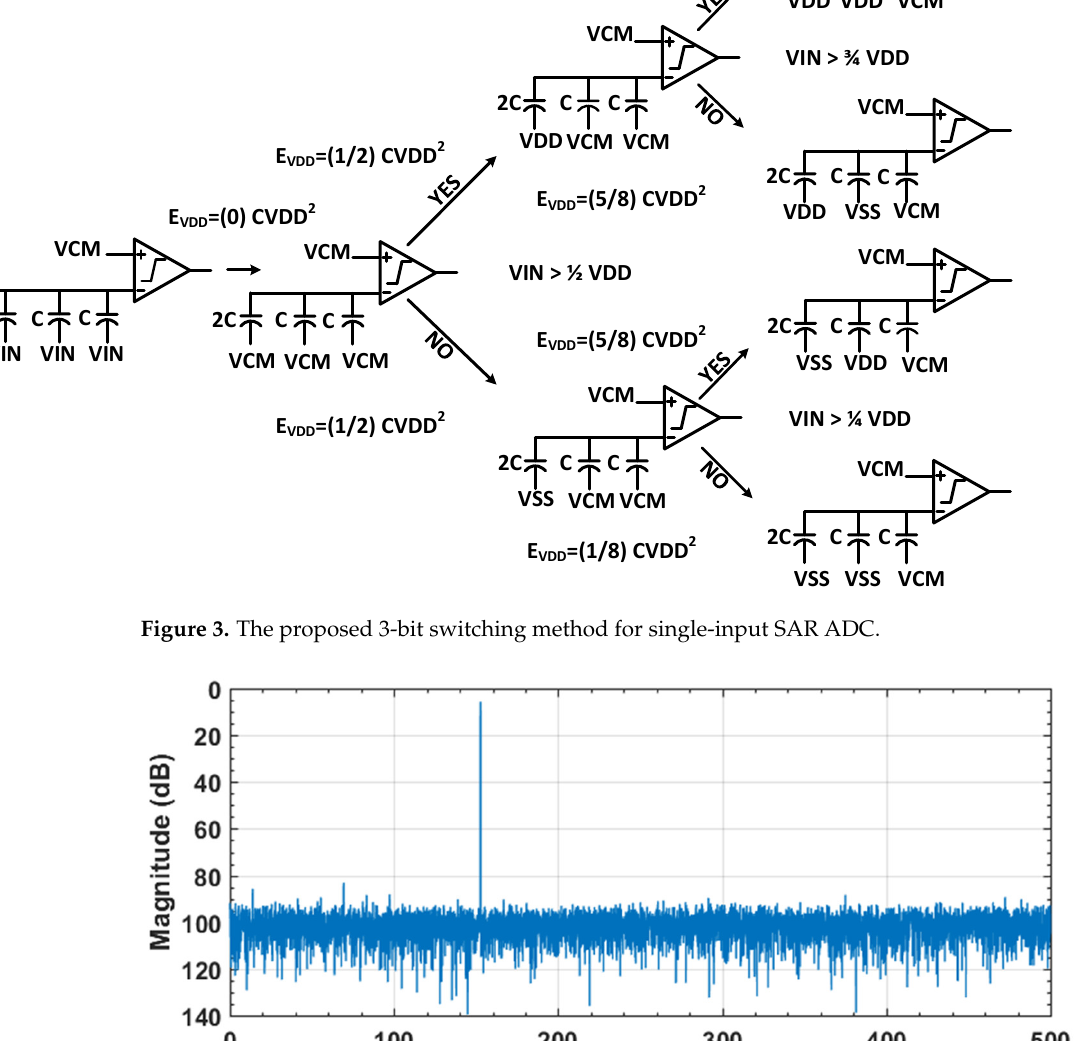
Figure 5. Static performance of the proposed switching with 1% unit capacitor mismatch. ( a ) DNL; ( b ) INL. Figure 6 shows the output of the capacitive DAC (DACP) settling of input signals according to the clock signal. An end-of-conversion (EOC) signal will be generated after the completion of the conversion cycle based on the asynchronous SAR logic. Figure 6. Simulation result of capacitive DAC.